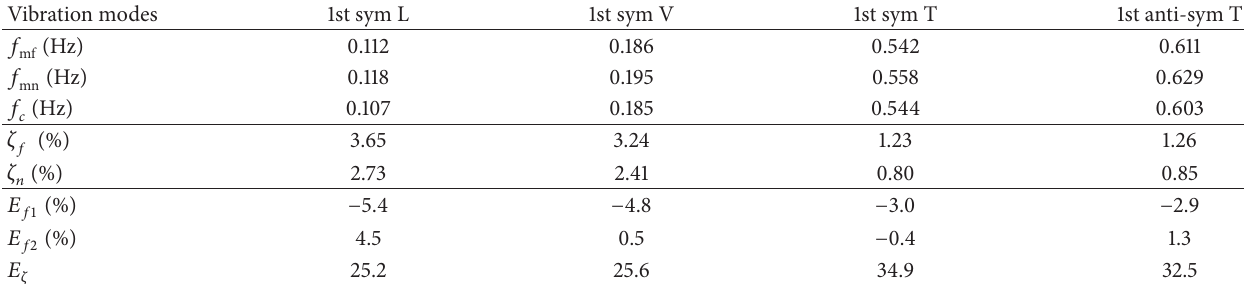
Table 1: Natural frequencies and modal damping ratios of the